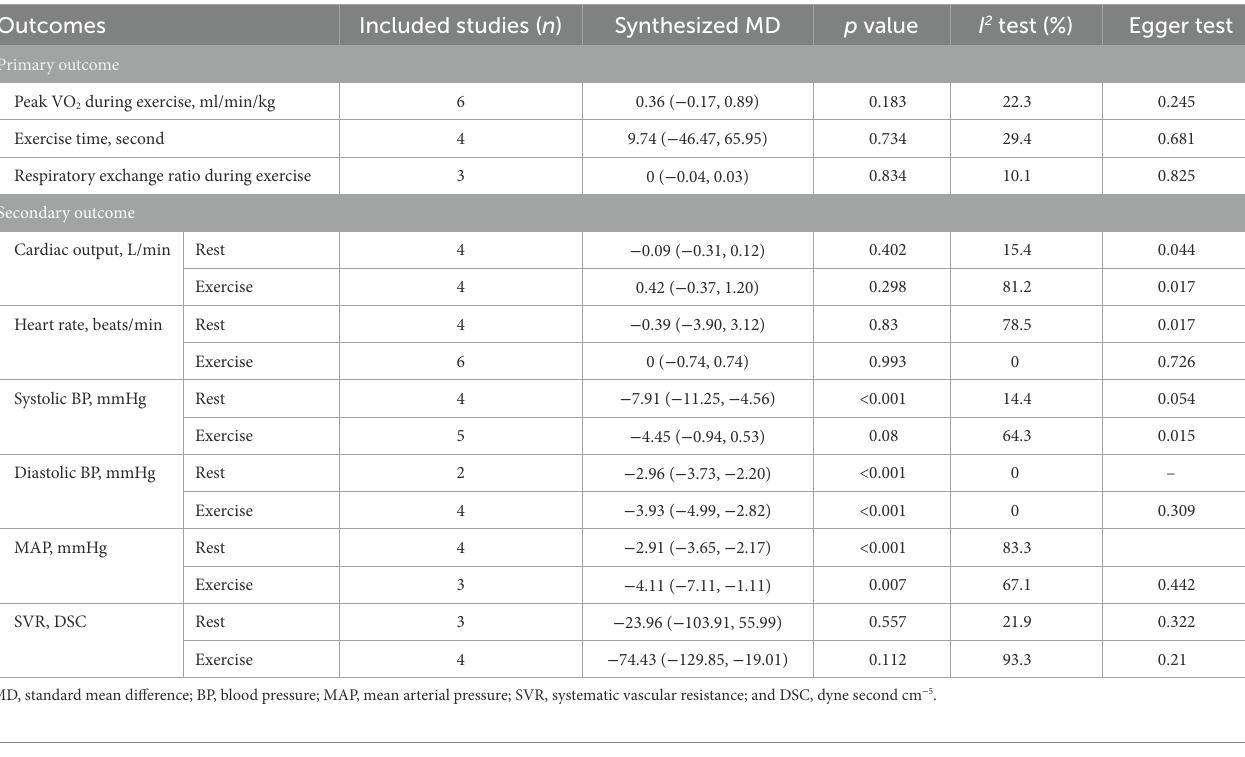
TABLE 3 Synthesized SMD of outcomes.